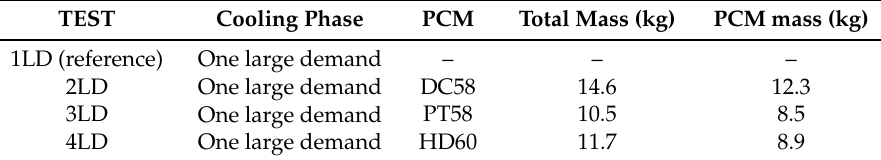
Table 4. Tests presented simulating one large demand.